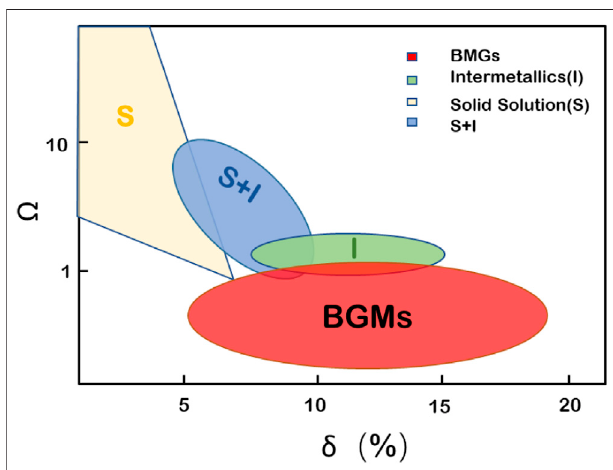
FIGURE 8 | Relationship between the parameters Ω and δ of multicomponent alloys and the amorphous phase region (Yang and Zhang, 2012).